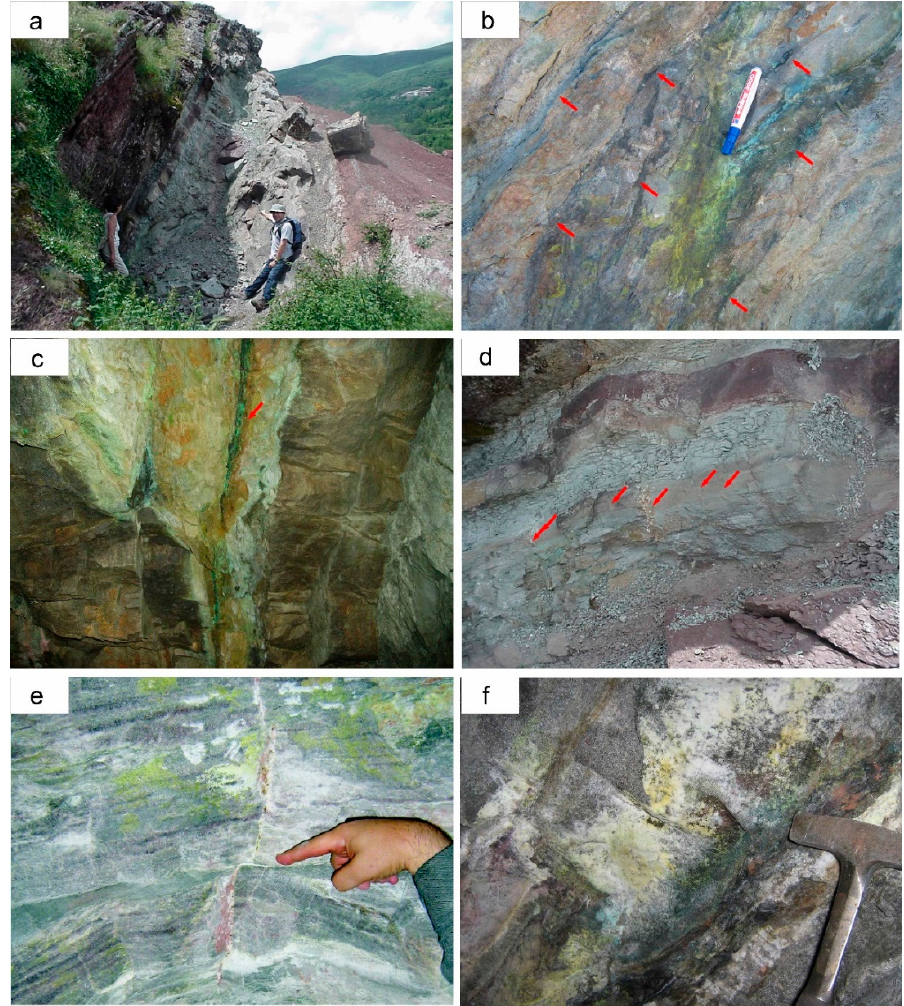
Figure 4. Field pictures showing the different mineralisation styles. ( a ) View of the upper outcrop (EUA), near Castell-estaó. Note the greenish sandstones sandwiched between the red units of sandstones (left) and shales (right); ( b ) Detail of the coal-rich units interbedded with sandstones; the yellow e ffl orescences are supergene uranyl vanadates, mainly carnotite; ( c ) Image of the coal seams in the lower mine (EUD), associated with copper enrichment (green crusts are brochantite); ( d ) Quartz-ankerite veins in necking domains (red arrows) in boudinaged sandstones embedded in shales; ( e ) Small veinlets displaced by layer-to-layer sliding; ( f ) E ffl orescences of secondary uranium carbonates at the top of the middle tunnel